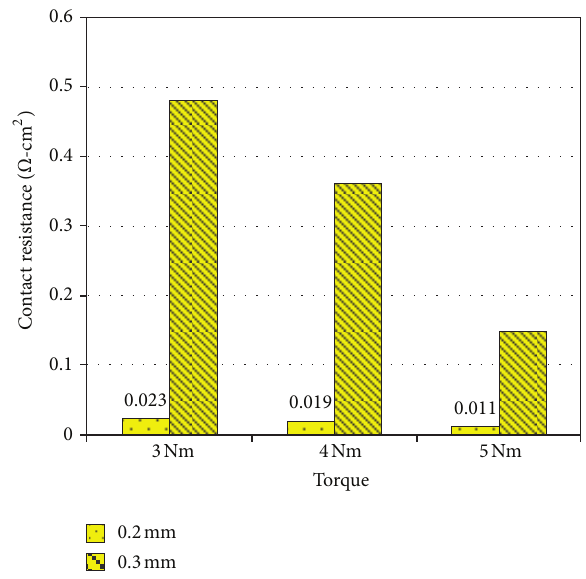
Figure 9: Contact resistances between the GDL and the BPP for different